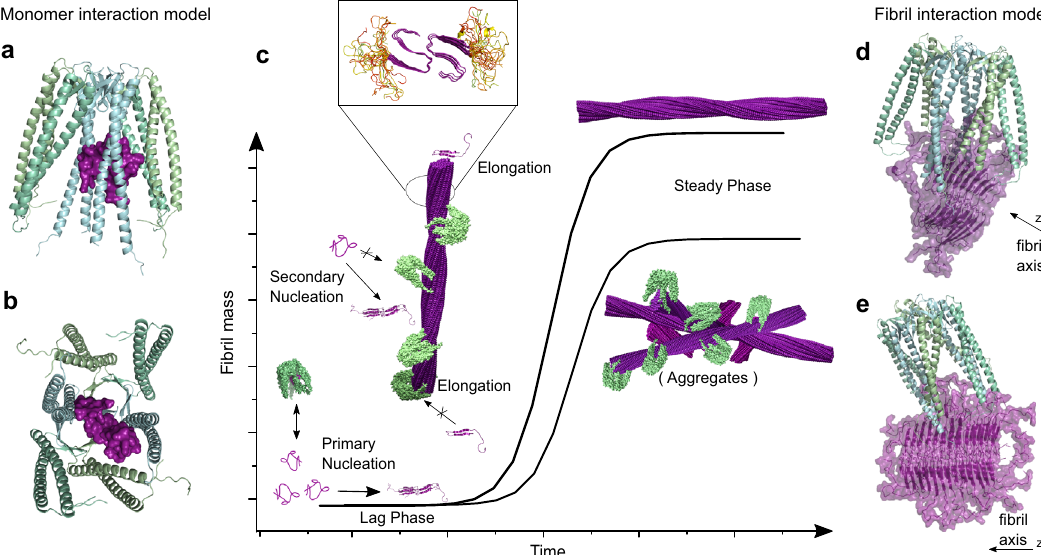
Fig. 5 Structural Model of inhibition of IAPP fi bril formation by PFD. Schematic model describing the inhibition mechanism of PFD on IAPP fi bril formation. PFD interacts with monomeric IAPP, but this transient interaction does not lead to a signi fi cant decrease of the lag-phase. a , b present docking models of the complex between monomeric IAPP (PDB: 2L86) and PhPFD (PDB: 2ZDI) based on NMR derived interaction information (Figs. 2 and 3). c Inhibition of secondary nucleation and elongation results from coverage of fi bril surface and ends by PFD (Fig. 4). The presence of PFD leads to a decreased steady phase fi bril mass (Fig. 1a), which results from the formation of less aggregates with an altered morphology (Fig. 1b). The inset zoom represents a model of IAPP fi bril structure with unfolded residues 1 – 12 in yellow and the structured fi bril core is represented in purple (from residues 13 – 37). d , e present docking models of PhPFD (PDB: 2ZDI) on IAPP fi bril (PDB: 6Y1A) surface and extremities, respectively, integrating structural information obtained by NMR (Figs. 2 and 3) and EM (Fig. 4); the black arrows indicate the fi bril axis with the tips pointing towards the fi bril